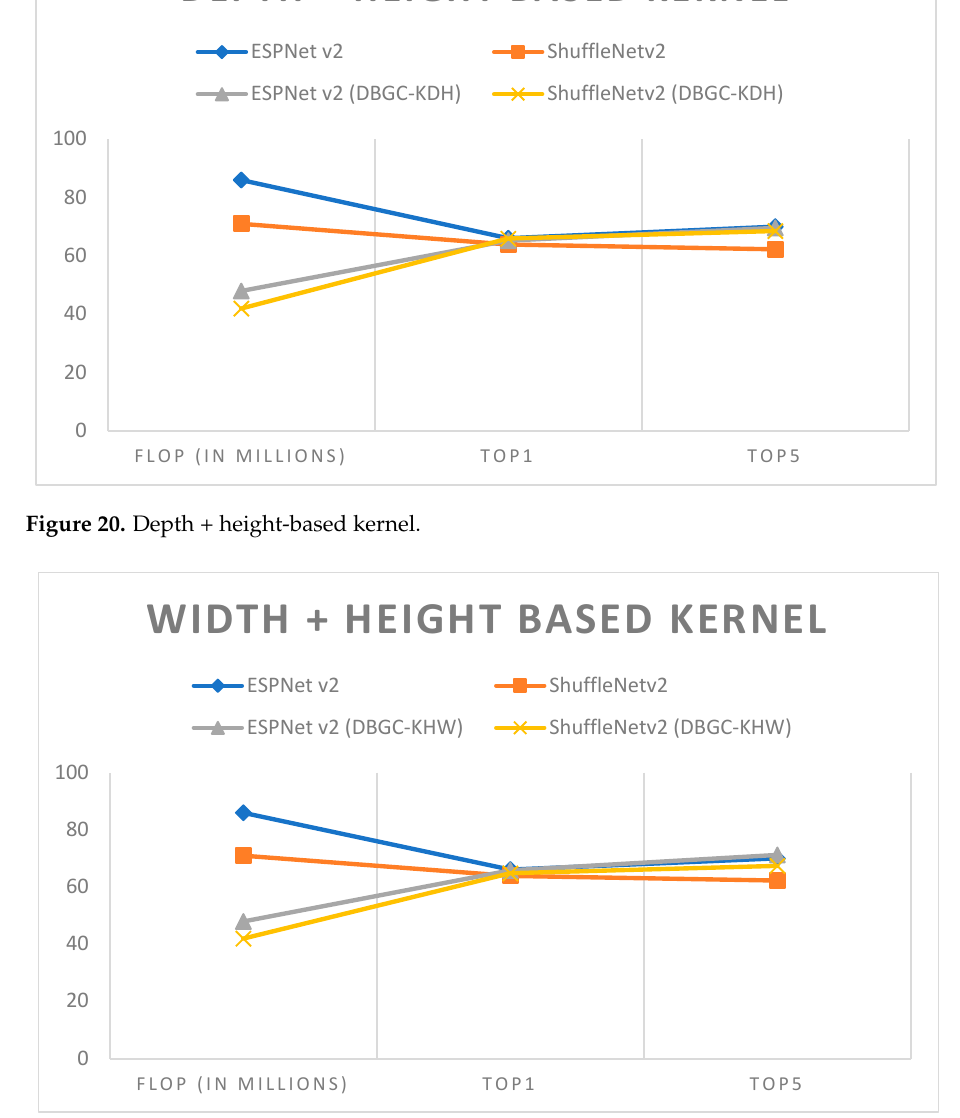
Figure 21. Height+width-based kernel. Figure 21. Height + width-based